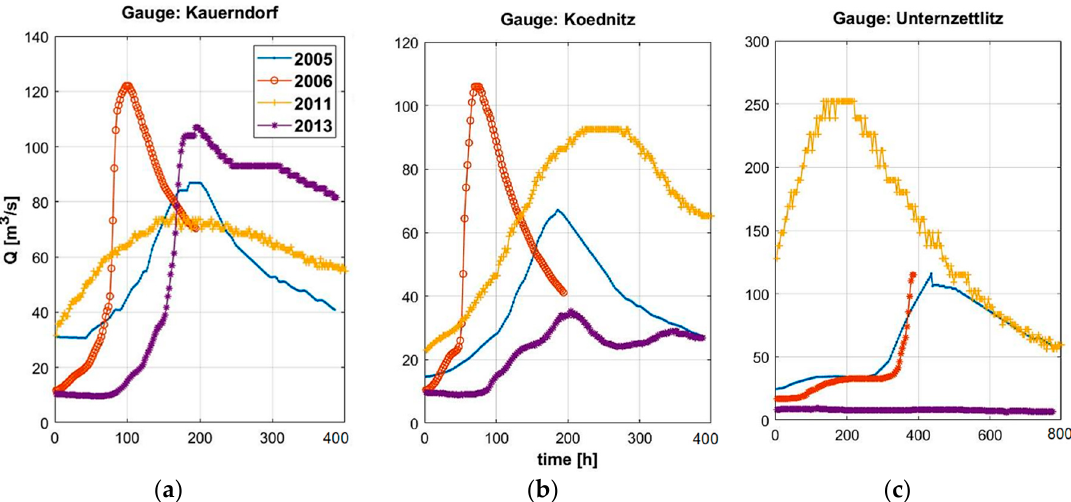
Figure 4. The four runoff events, February 2005, May 2006, January 2011, May 2013, selected for the validation plotted for the three gauges of ( a ) Kauerndorf, ( b ) Ködntiz and ( c ) Unternzettlitz.